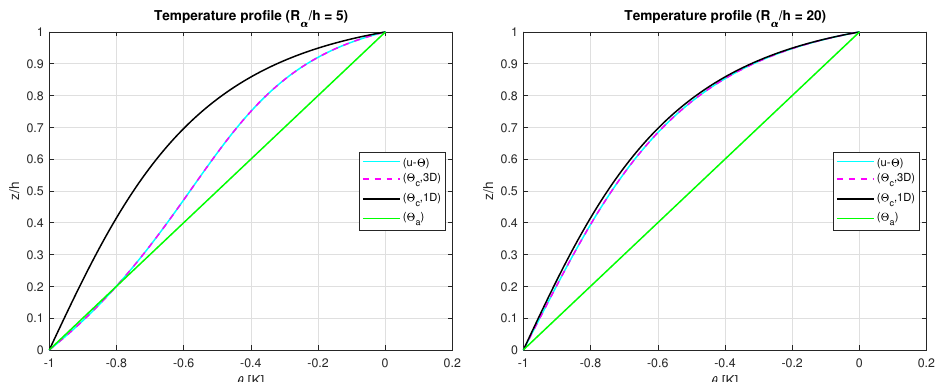
Figure 12. Fourth benchmark, temperature profiles for thick and moderately thick simply supported spherical shell with one FGM ( p = 2) layer.